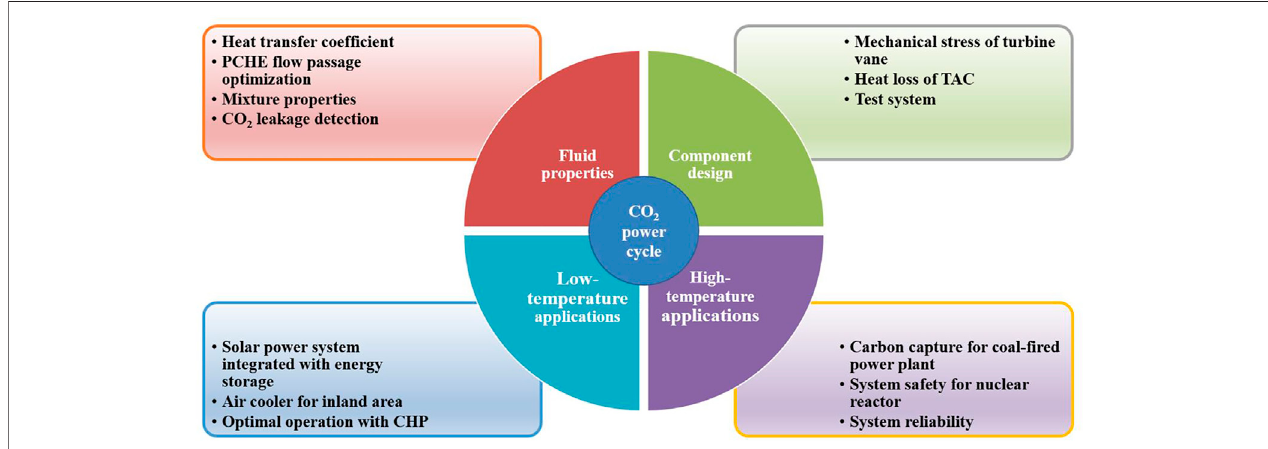
FIGURE 10 | Technical challenges and possible future developments of CO 2 power